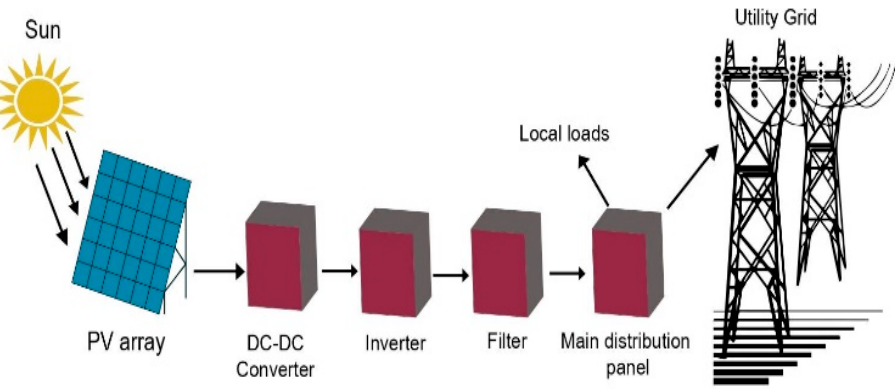
Figure 6. Integration of solar energy with the existing utility grid.